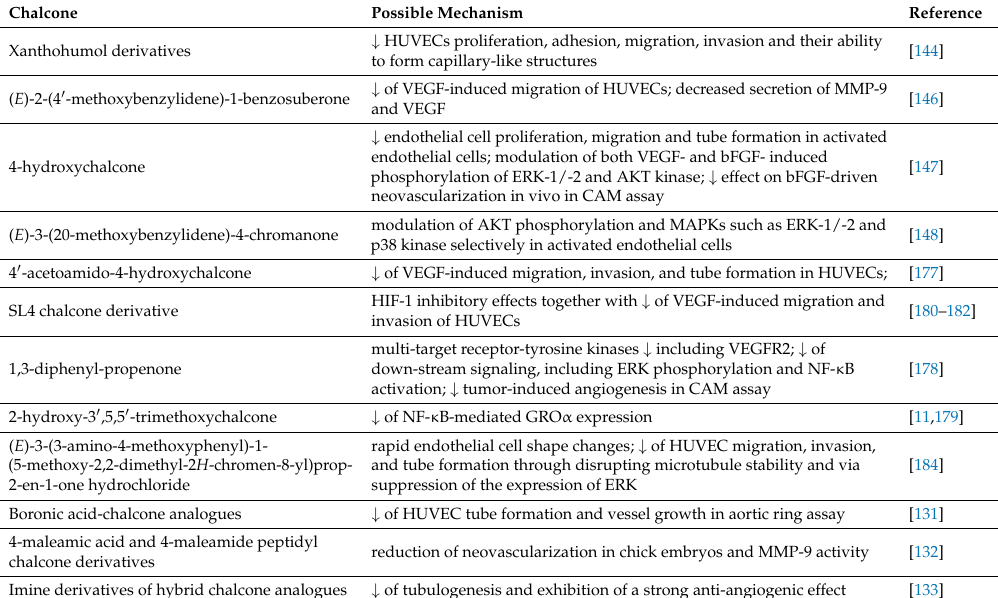
Table 4. Antiangiogenic effect of selected synthetic